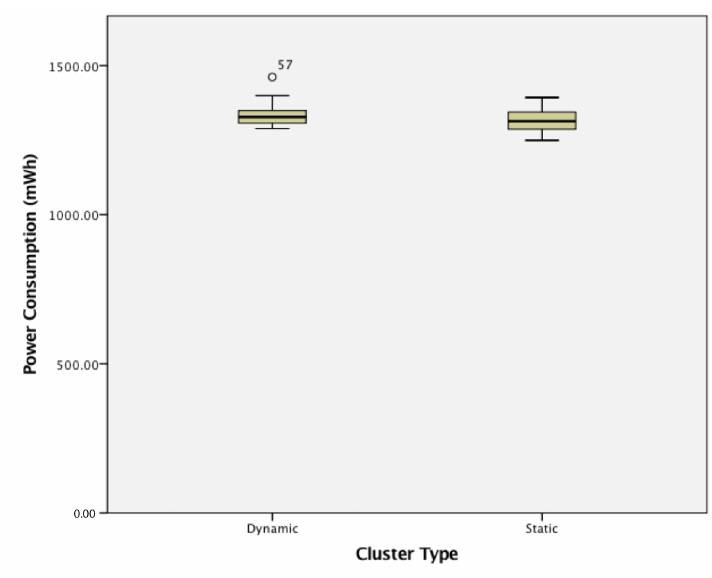
Figure 26. Power consumption of static and dynamic wireless sensor